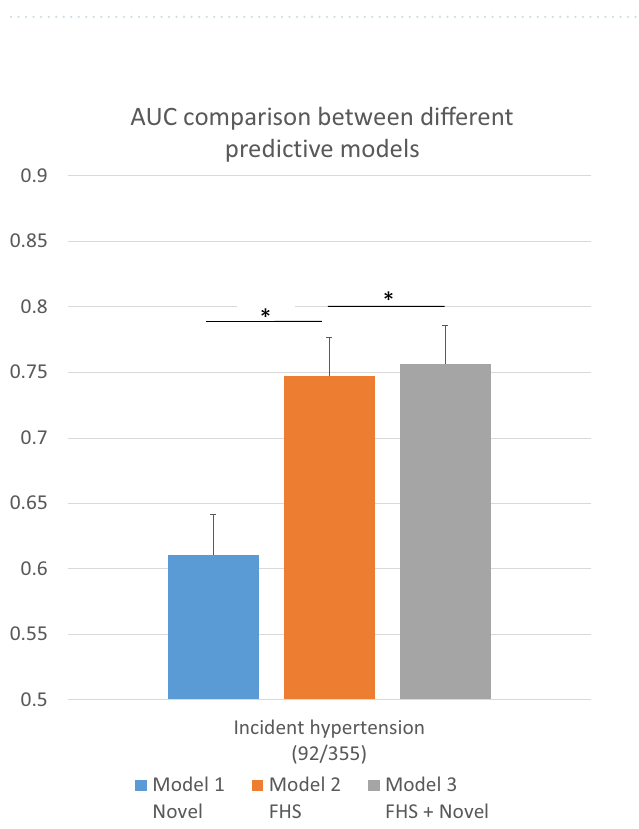
Table 2. Effect of adjustments on the association between selected lipids and blood pressure. Table shows the identified lipids through discovery and replication (Fig. 2). Model 1 was performed in discovery, replication and combined data with age and sex as covariates; Model 2 was performed in the combined data with additional adjustment for BMI, HDL-C, TC, lipid-lowering medication and type 2 diabetes status based on model 1.